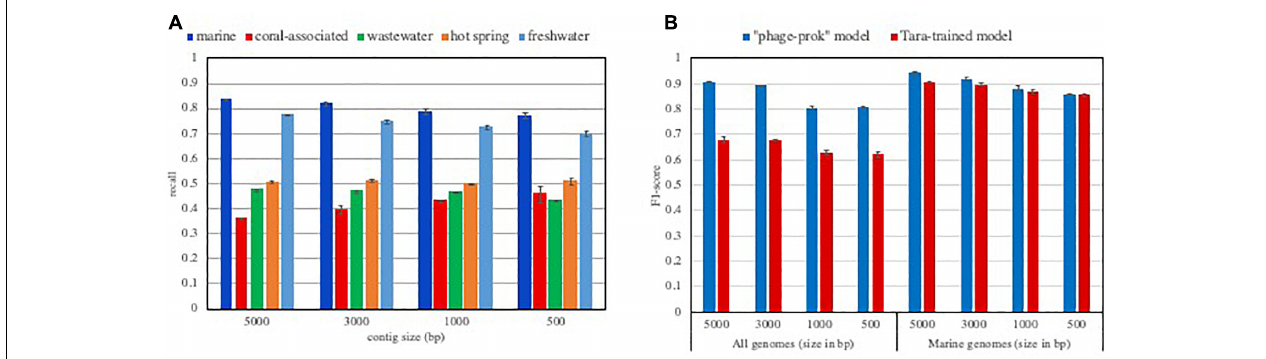
FIGURE 1 | Influence of the training set composition on the model performances. (A) Recall of VirFinder “phage-prok” model on viral contigs isolated in various aquatic ecosystems. The recall was assessed for VirFinder “phage-prok” model when considering viral contigs isolated in various aquatic ecosystems (pelagic, freshwater, hot spring, coral-associated and wastewater). The sequences were downloaded from the IMG V/R env database (methods described in Supplementary File S1 and list of metagenomes used in Supplementary File S2 ). The viral sequences were broken down to 5000, 3000, 1000, and 500 bp and used to evaluate VirFinder “phage-prok” model. The mean of the recall was calculated for three evaluation sets of 2000 viral sequences each with the exception of the coral-associated evaluation sets composed of 200 viral examples due to the low amount of sequence available for this ecosystem. The error bars correspond to the standard deviation on the three measures. (B) F1-score of classifiers trained on Tara Oceans Metagenomes. Tara-trained models were trained on 10 000 viral and 10 000 prokaryotic sequences from Tara Oceans metagenomes and viromes broken down to 5000 bp. Previous cleaning steps were performed to ensure a low contamination content of the training set (see Supplementary File S1 ). The F1-score of a Tara-trained model and of VirFinder’s “phage-prok” model was calculated for evaluation sets composed of viruses and prokaryotes isolated in a marine ecosystem (“marine genomes”) or an evaluation set composed of viral and prokaryotic genomes regardless of their origin (“all genomes”). For the “marine evaluation set,” genomes from phages and prokaryotes isolated in marine ecosystems were downloaded from Genbank and the Patric database, respectively, and the sequences were broken down to 5000, 3000, 1000, and 500 bp (see methods in Supplementary File S1 and list of genomes available in Supplementary File S2 ). The “all genomes” evaluation set is composed of genomes from phages and prokaryotes from RefSeq database published after 2014 (see methods in Supplementary File S1 and list of genomes available in Supplementary File S2 ). The mean of the F1-score was calculated for three evaluation sets composed of 2000 viral sequences and 2000 prokaryotic sequences. The error bars correspond to the standard deviation on the three